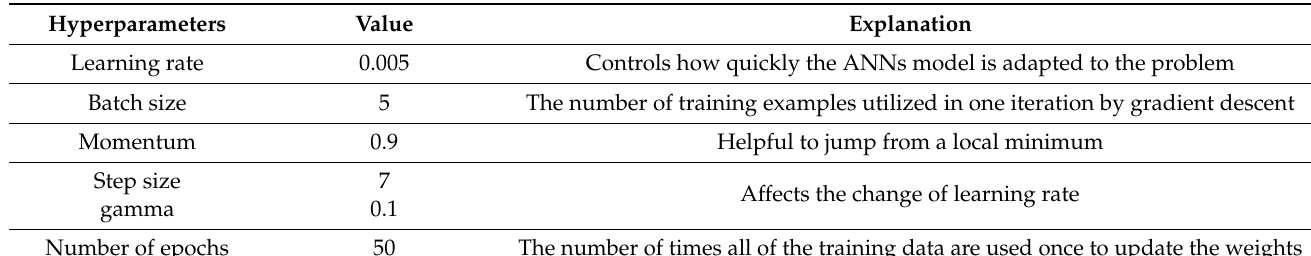
Table 1. Final values of hyperparameters used in the ANNs